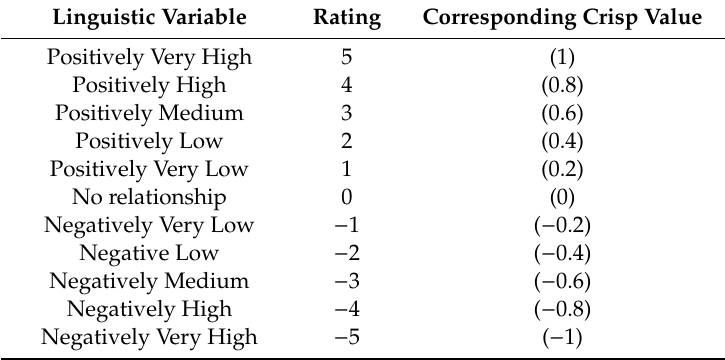
Table 1. Membership functions for the fuzzy weights.